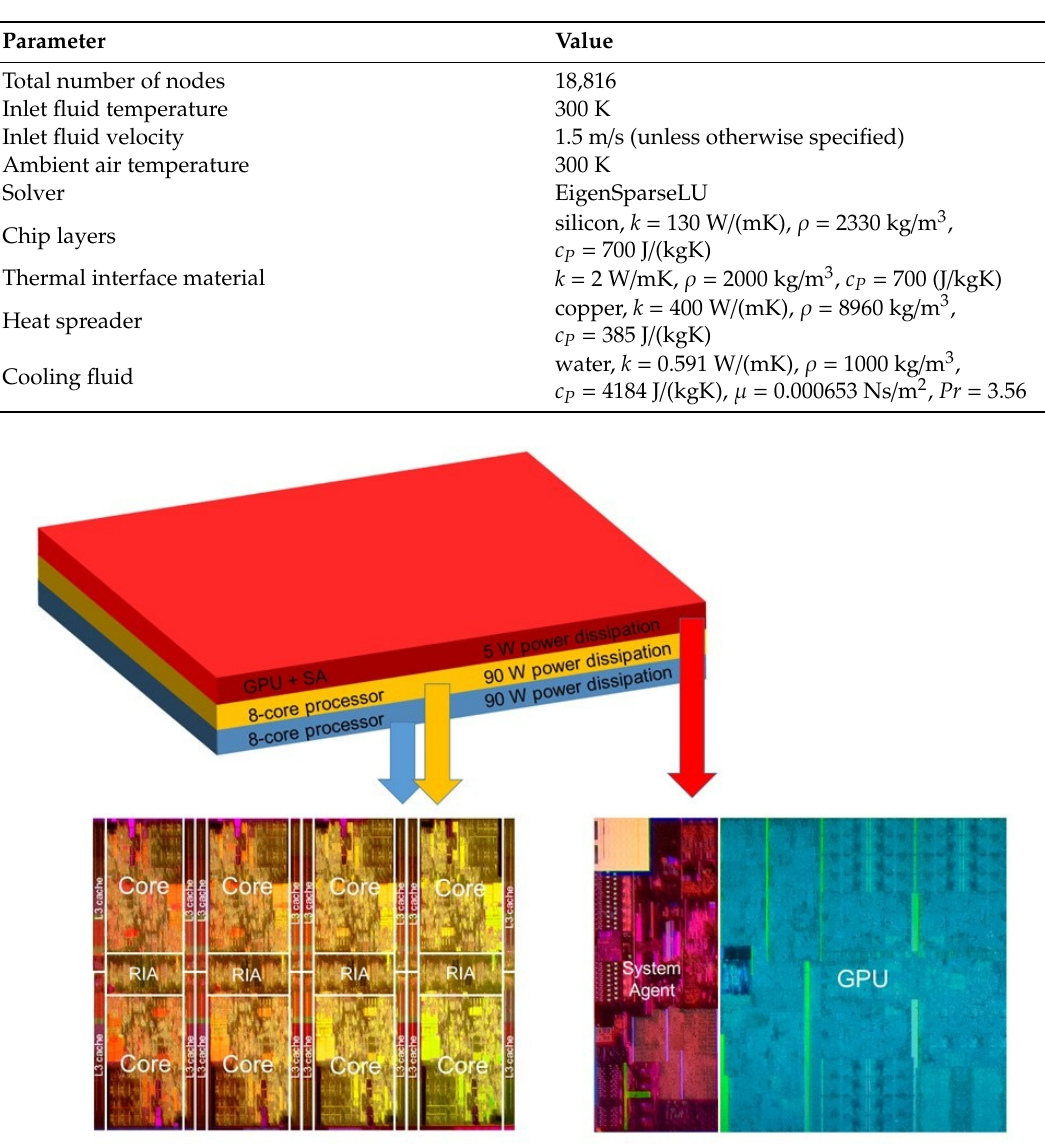
Figure 4. The model of the 3D processor based on the floorplan of Intel i9-9900K. The 3D chip contains two octa-core processors in two layers. The system agent and the GPU occupy the third layer. The total die area is about 107 mm 2 . The power density is about 3.2 × higher than in the original Intel processor. A more detailed view of all layers is shown in Figure 5.